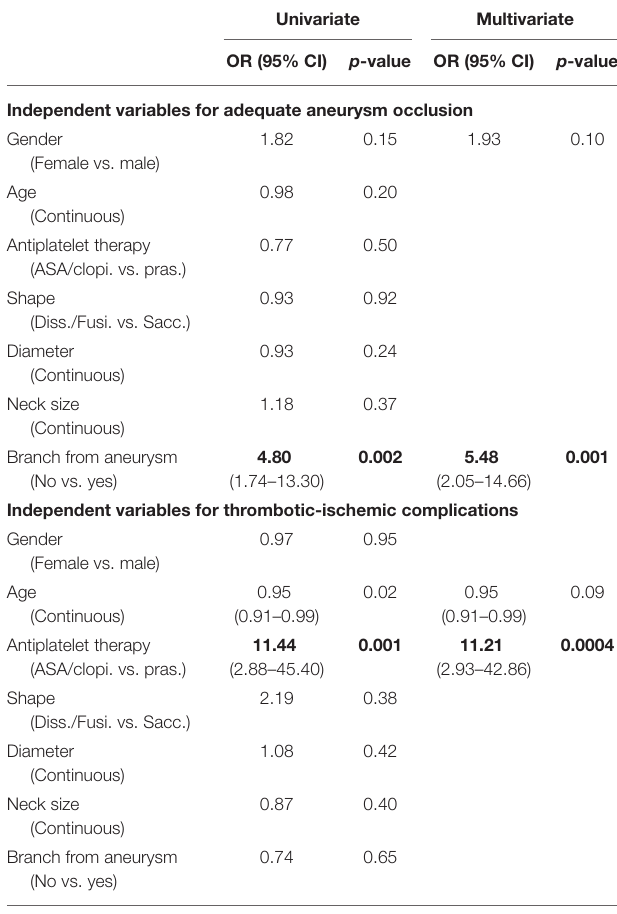
TABLE 2 | Multivariate analysis of predicting factors for treatment-related complications (thrombotic or ischemic events) and of predicting factors for aneurysm occlusion conducted on 158 cases at 6-month follow-up.